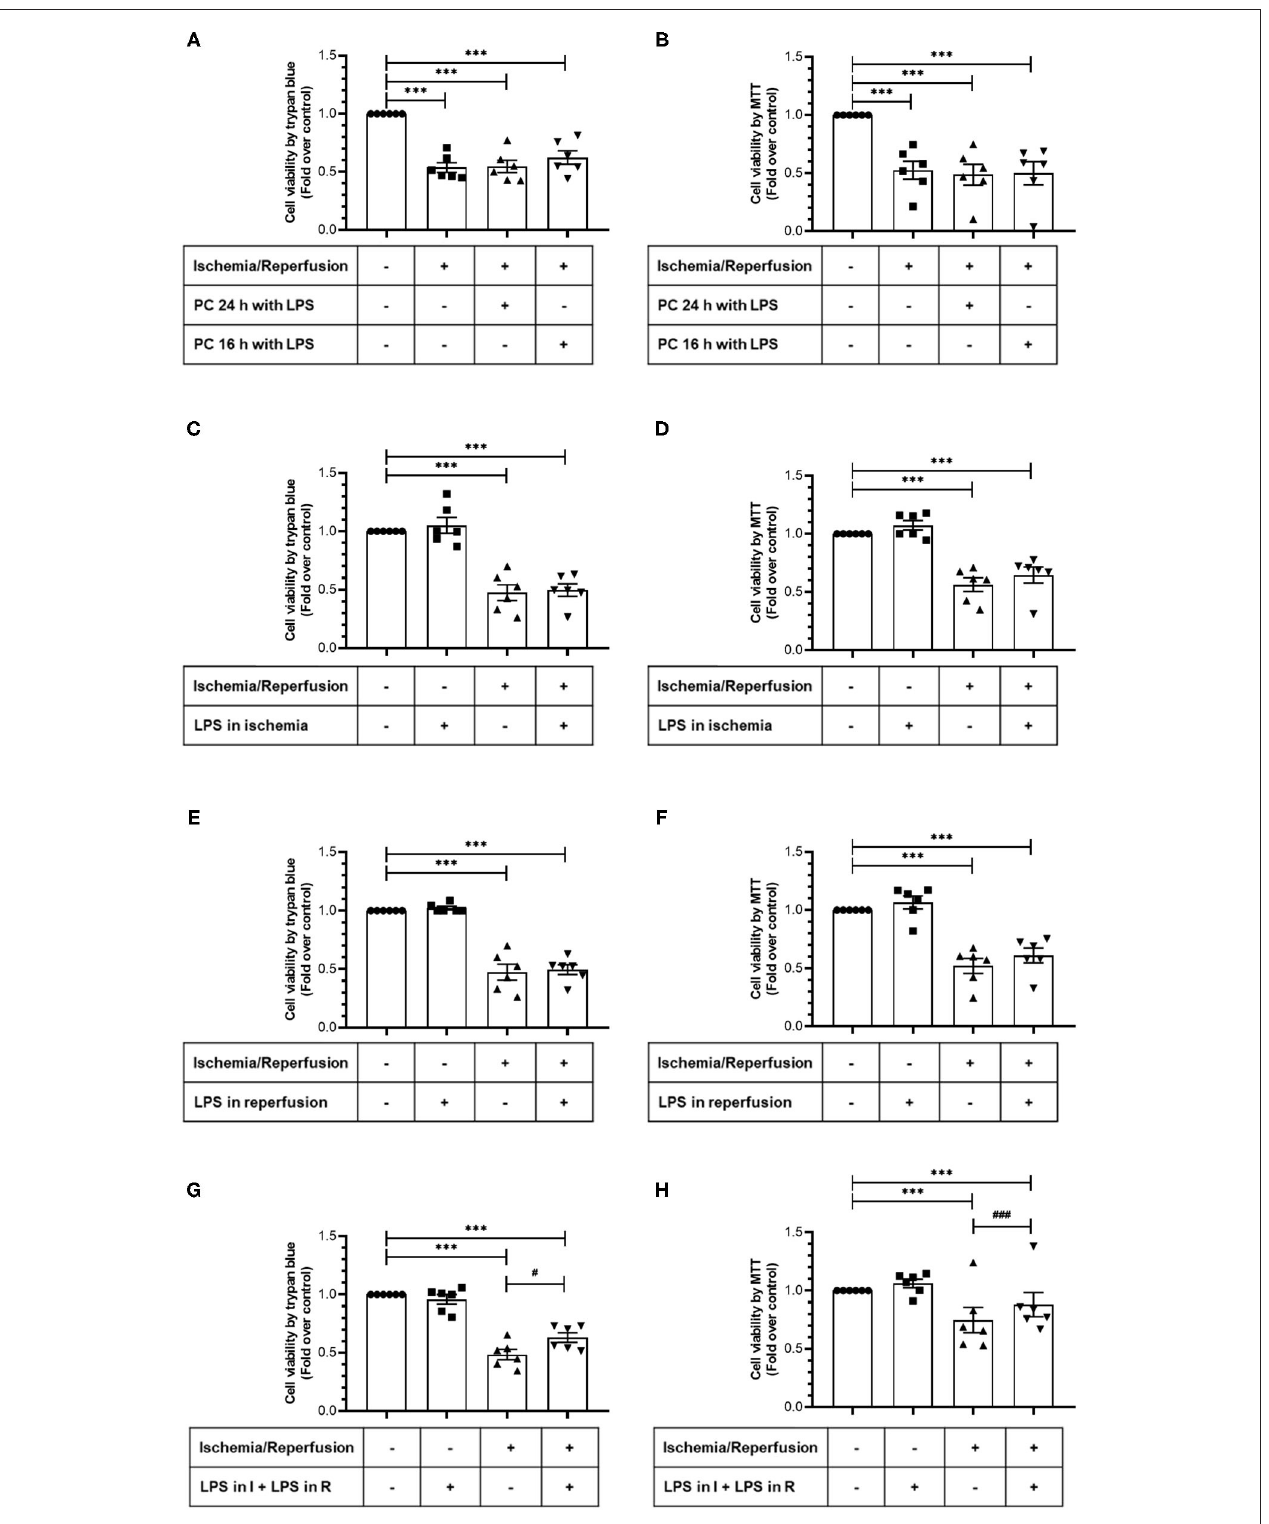
FIGURE 2 | Lipopolysaccharide (LPS) increases the viability of cardiac fibroblasts exposed to simulated ischemia/reperfusion (sI/R). Cardiac fibroblasts were subjected to 8h of ischemia and 16h of reperfusion (sI/R). Cell viability was determined using the trypan blue exclusion test (A,C,E,G) or the MTT assay (B,D,F,H)